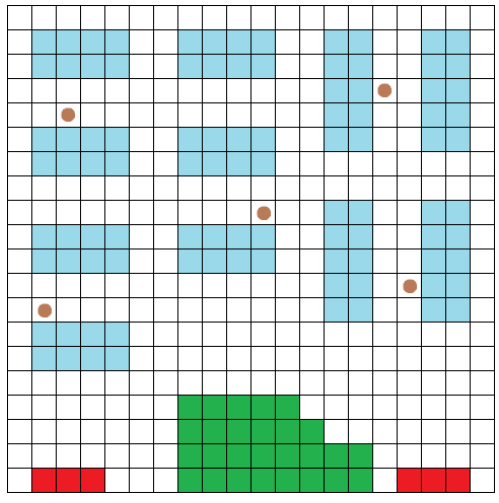
Figure 2. An example of a 20 × 20 warehouse. Unoccupied space is indicated by white tiles, while blue tiles indicate product shelves, green tiles indicate the warehouse office, red tiles indicate the point of delivery, and brown marked tiles indicate robot